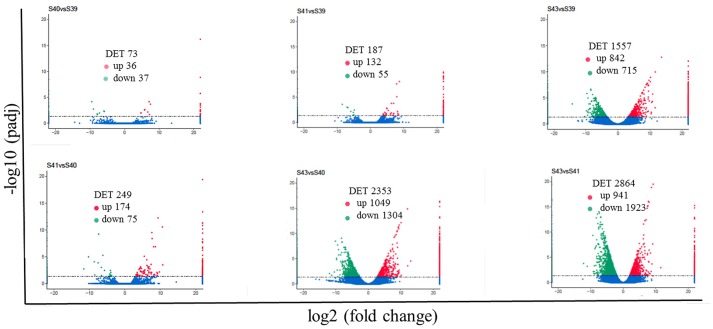
Pair-wise comparisons reveal that S43 tail has the most number of differentially expression transcripts (DETs, q < 0.05) during natural metamorphosis. Volcano plot of DETs in the tail for six different comparison groups. X axis represents fold-change (log2FC) of the DETs and the Y axis represents the –log10padj [adjusted P-value (q-value)] value of the DET, with 0.05 set as the significance cutoff level. Up-regulated DETs are shown in red while down-regulated ones in green; non-significantly DETs are presented in blue.